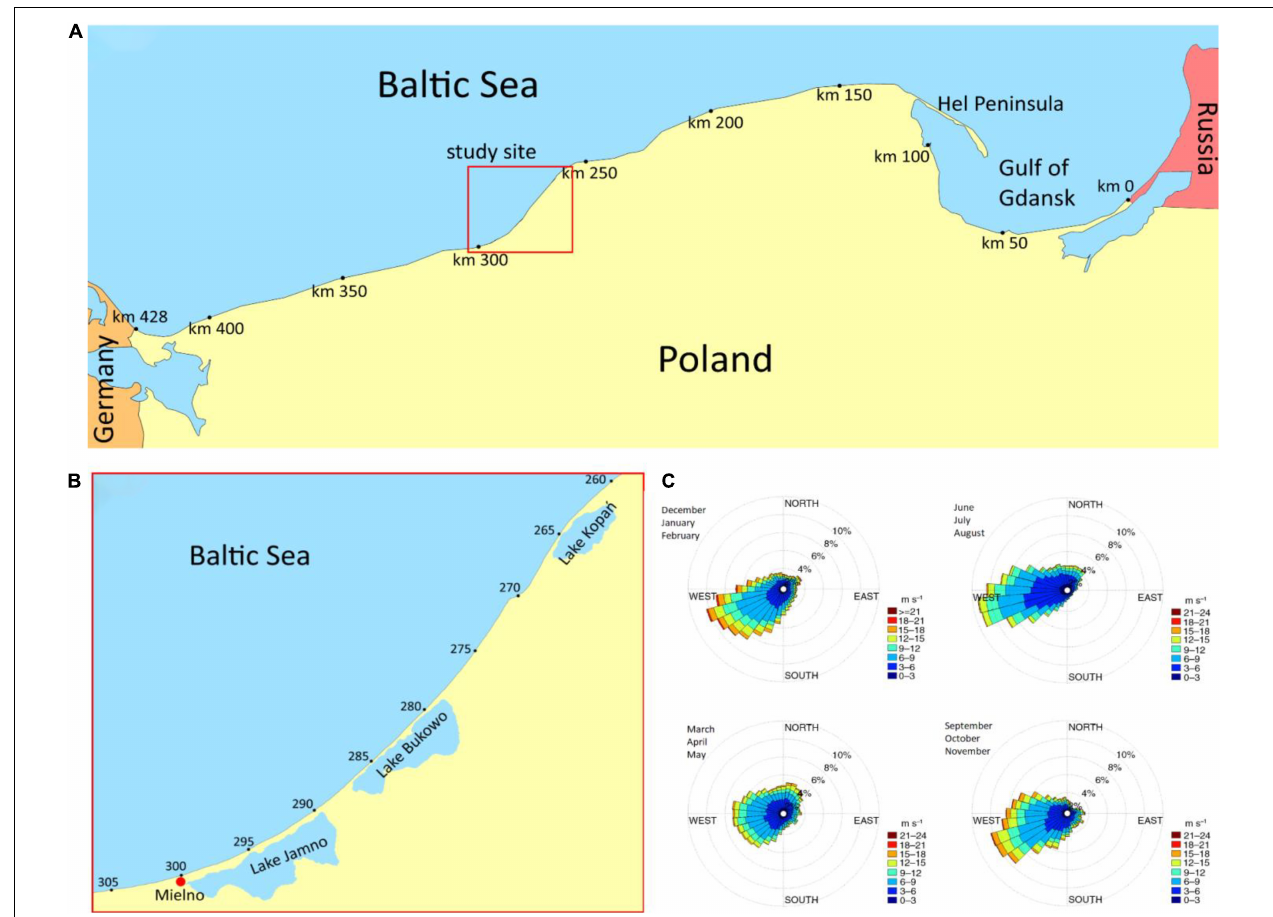
FIGURE 1 | Study area: global view (A) , study area (B) , spring, summer, autumn and winter wind roses, after [***] (C) .